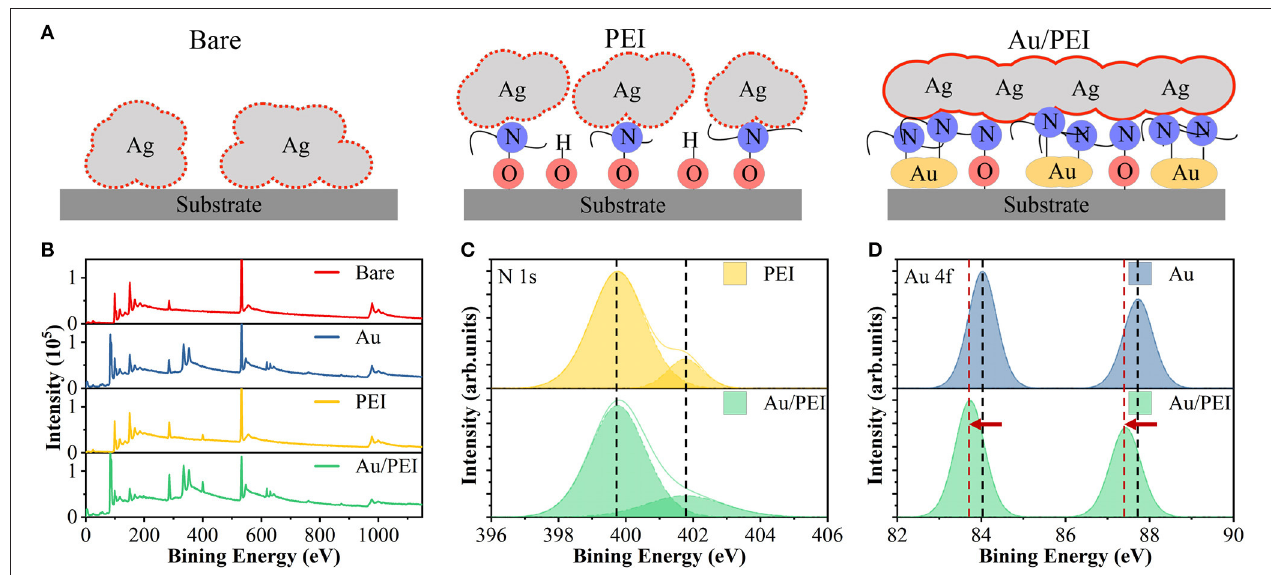
FIGURE 1 | (A) Conceptual diagram of the growth mechanism of Ag film on bare substrate, conventional single-layered PEI, and novel bilayered Au/PEI NISLs. (B) XPS survey spectra of bare Si substrate before and after coating with Au, PEI, and Au/PEI NISLs. High-resolution normalized XPS spectra of (C) N1s and (D) Au 4f on different